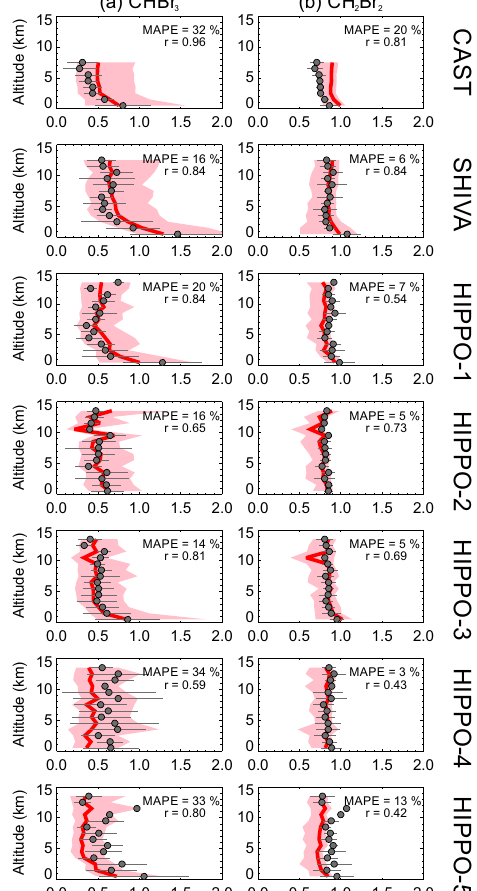
Figure 10. Compilation of modelled vs. observed tropical profiles of (a) CHBr 3 and (b) CH 2 Br 2 mixing ratio (ppt) from recent air- craft campaigns. Details of campaigns given in Sect. 2.4. Cam- paign mean observed profiles derived from tropical measurements only and averaged in 1km vertical bins (filled circles). The hori- zontal bars denote ± 1 σ from the observed mean. The correspond- ing multi-model mean profile (red) and model spread (shading) are shown. All models were included in the MMM with the excep- tion of STAG (see Sect. 3.1.2). Models were sampled in the same space/time as the observed values, though for the comparison to CAST data, a climatological model profile is shown. The model– measurement correlation coefficient ( r ) and the mean absolute per- centage error (MAPE, see main text) between the two are indicated in each